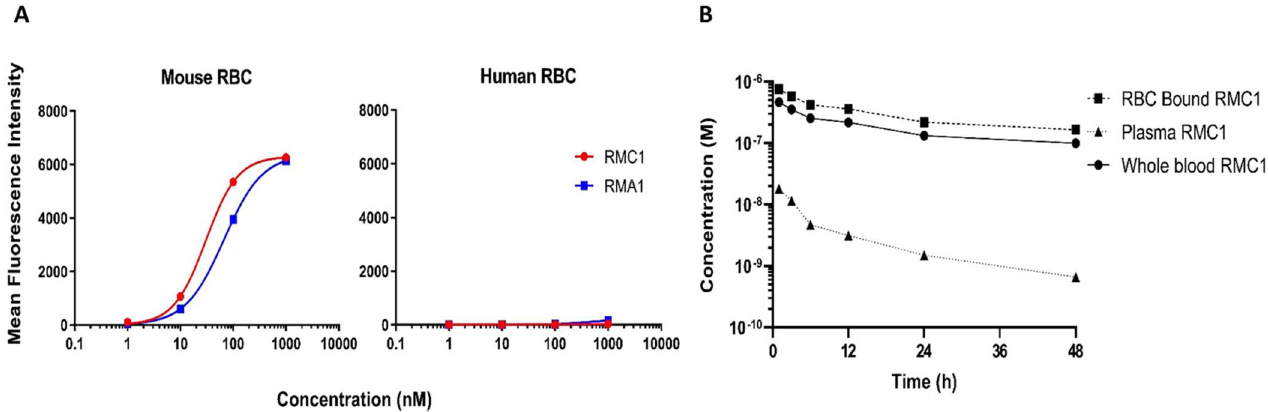
Figure 3. Pharmacokinetics of anti-RBC sdAbs (RMC1) in mice: ( A ) A derivative library was constructed from RB12 and RE8 via random mutagenesis, and affinity maturation was performed through additional panning and screening procedures to isolate clones with higher affinity to mouse RBC. Further binding assessment of two derivative clones, RMA1 and RMC1, was carried out via flow cytometry. There is no binding detected to human RBC up to 1 µM of purified sdAbs, while improved binding affinity to mouse RBC was observed with the estimated K D of 66.9 nM and 30.3 nM for RMA1 and RMC1, respectively. ( B ) The concentration-time profile after an IV administration of 1 mg/kg of RMC1 with a tracer dose of 125 I label is shown. RBC and plasma were separated from whole blood, TCA precipitated, and radioactivity counted. Plasma half-life improved from 5 h for the two low-affinity RBC-binding sdAbs RE8 and RB12 to 60 h for the affinity-maturated sdAb RMC1. Data points represent the mean concentration ( n = 3), and error bars denote the standard deviation of the mean.